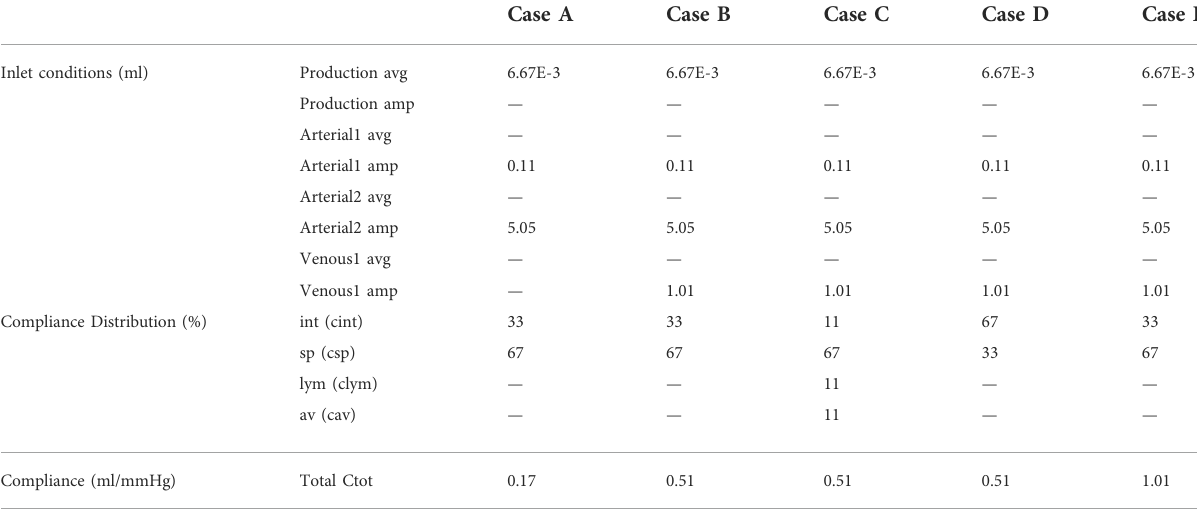
TABLE 3 Overview of inlet conditions with average (avg.) and amplitude (amp.) and distribution of and value of compliance for cases A, B, C, D, and